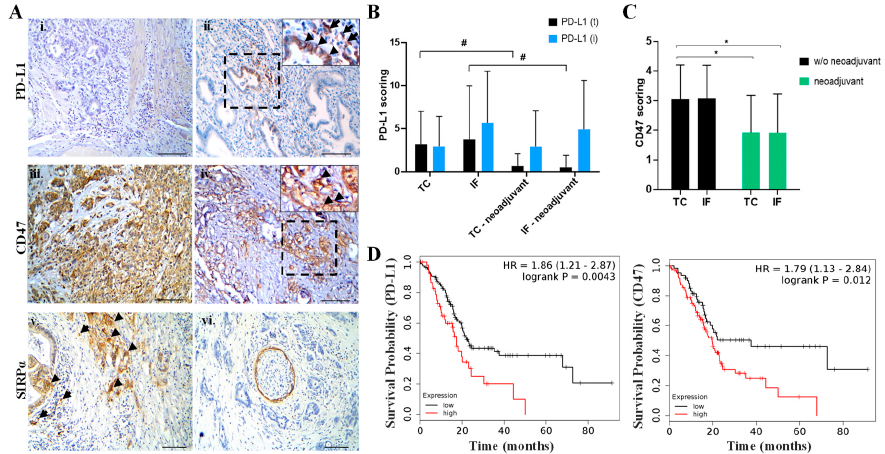
Figure 6. Status of programmed death ligand 1/programmed death 1 (PD-L1/PD-1) and